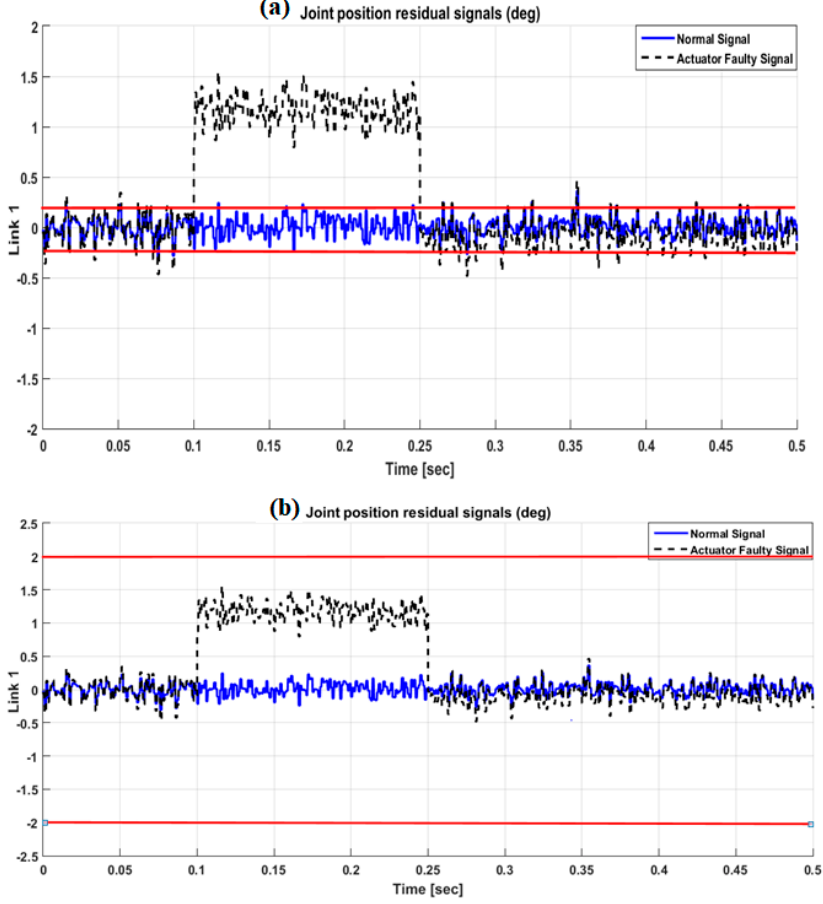
Figure 7. The effect of incorrect threshold values for fault detection.